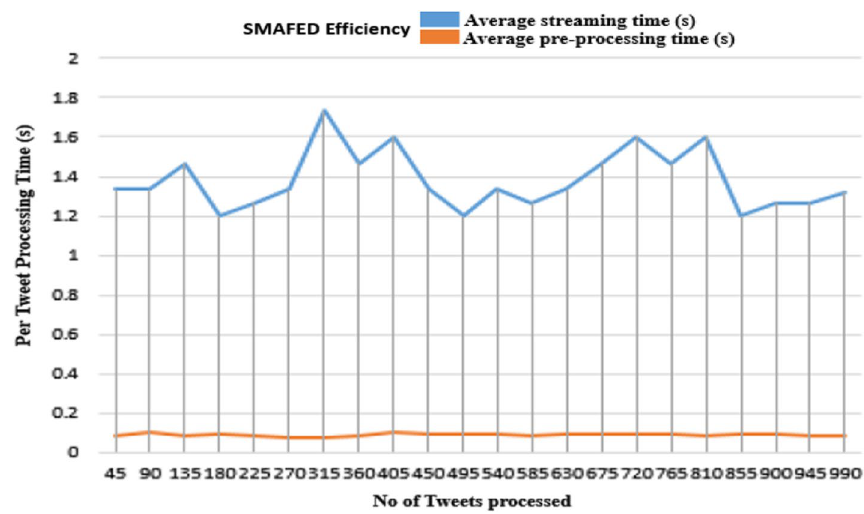
Fig. 4 SMAFED Evaluation. The average processing time for each tweet is 0.125 s